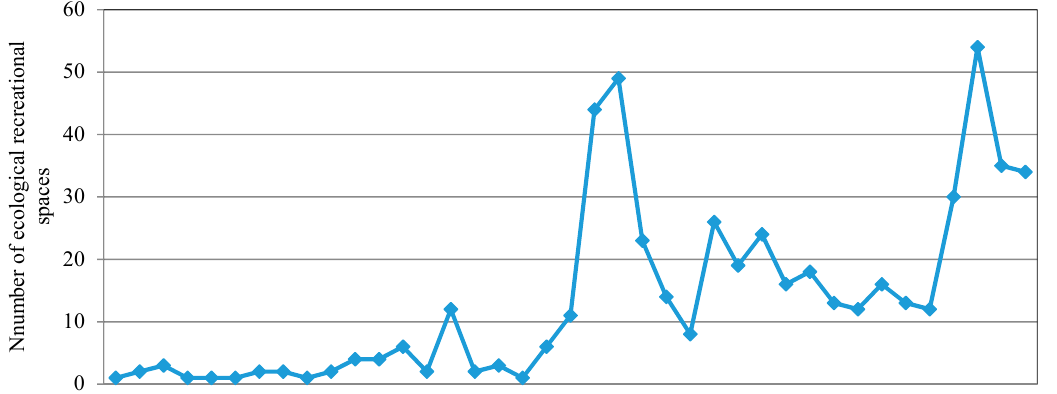
Figure 2. Number of ecological recreational spaces as a function of time.